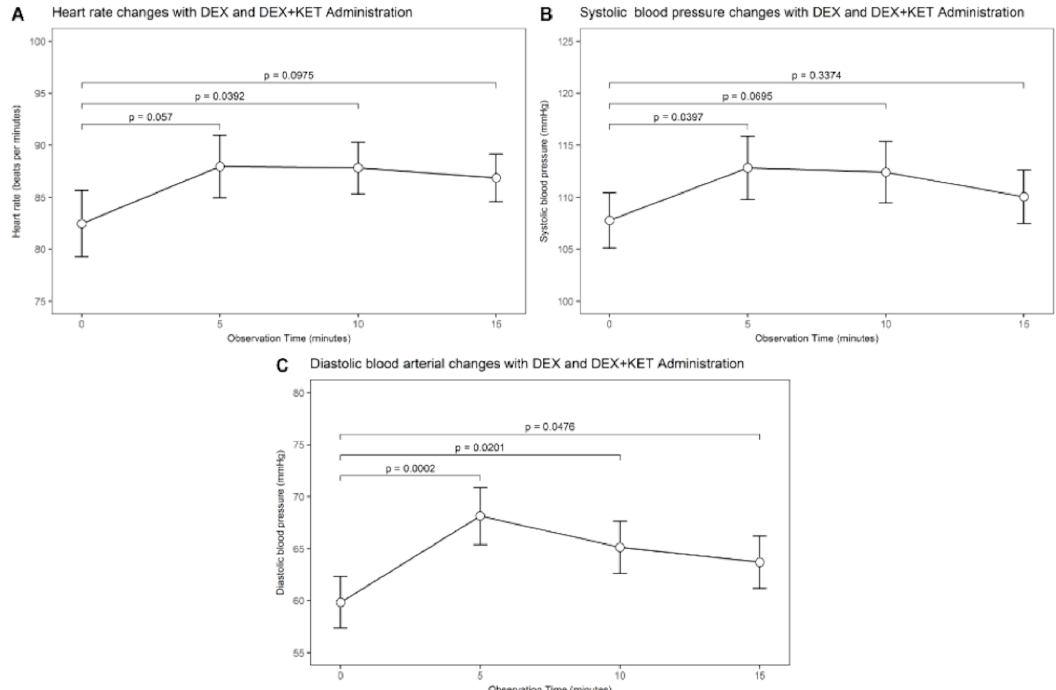
Figure 5. Changes hemodynamics with dexmedetomidine (baseline) and after ketamine administration. In the x-axis, the first data point is the mean baseline hemodynamic value, and the second, third, and fourth points are the mean hemodynamic value after 5, 10, and 15 min of ketamine administration. ( A ) Comparison of baseline and post ketamine heart rates. Compared with baseline, the administration of ketamine did increase the mean heart rate significantly only after 10 min of ketamine administration ( p = 0.0392). ( B ) Comparison of baseline and post ketamine systolic blood pressures. Compared with baseline, the administration of ketamine did increase mean systolic blood pressure significantly after 5 min of ketamine administration ( p = 0.0397) ( C ) Comparison of baseline and post ketamine diastolic blood pressures. Compared with baseline, the administration of ketamine did increase mean diastolic blood pressure significantly after 5 min of ketamine administration ( p = 0.0002), 10 min ( p = 0.0201), and 15 min ( p = 0.0476)). All p -values were adjusted for multiple comparisons (DUNNETT adjustment for testing differences with a control